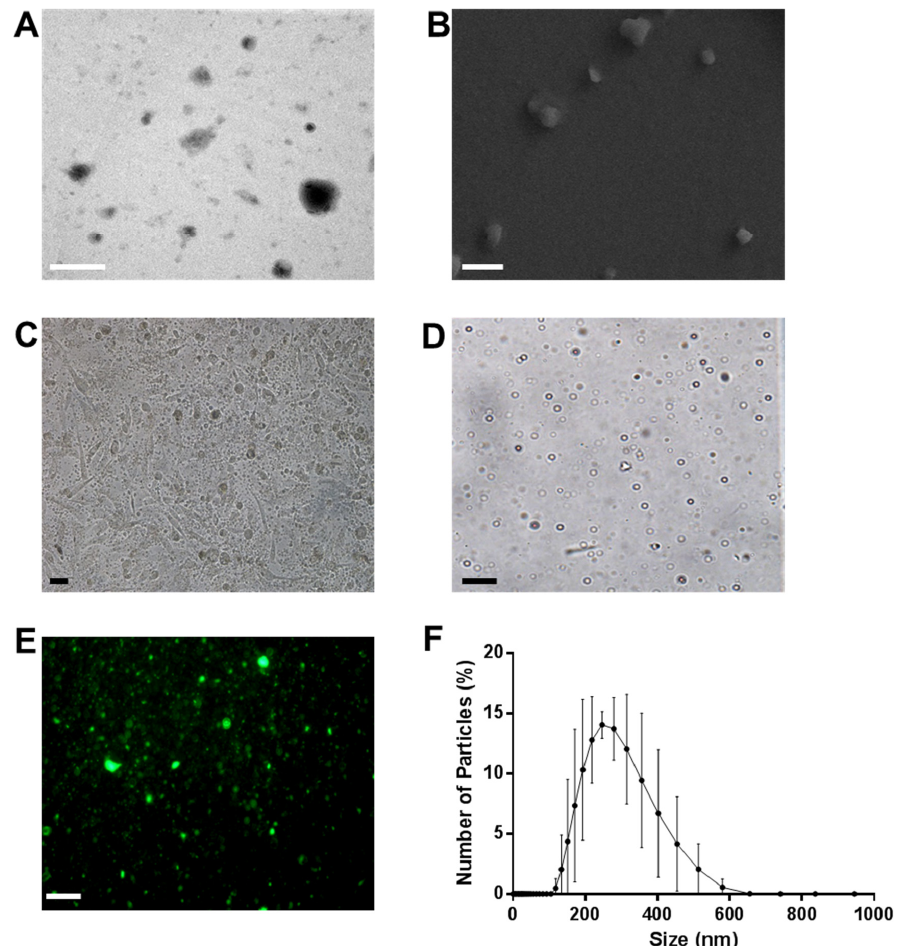
Figure 2. Characterization of oxygen nanobubbles (ONBs) with a lipid ratio of 85:8:7 ( A ). electron microscopy (TEM) image, with a scale bar of 500 nm. ( B ) Scanning electron microscopy (SEM) Transmission electron microscopy (TEM) image, with a scale bar of 500 nm. ( B ). Scanning electron image, with a scale bar of 1 µ m. ( C ) MDA-MB-231 cells with 10% ONBs in the media and a scale bar of microscopy (SEM) image, with a scale bar of 1 µm. ( C ). MDA-MB-231 cells with 10% ONBs in the media and a scale bar of 10 µm. ( D ). Micro-sized bubbles with a scale bar of 10 µm. ( E ). Fluorescent 10 µ m. ( D ) Micro-sized bubbles with a scale bar of 10 µ m. ( E ) Fluorescent bubbles with a scale bar of bubbles with a scale bar of 10 µm. ( F ). Combined DLS data of ONBs with n = 6. 10 µ m. ( F ) Combined DLS data of ONBs with n =